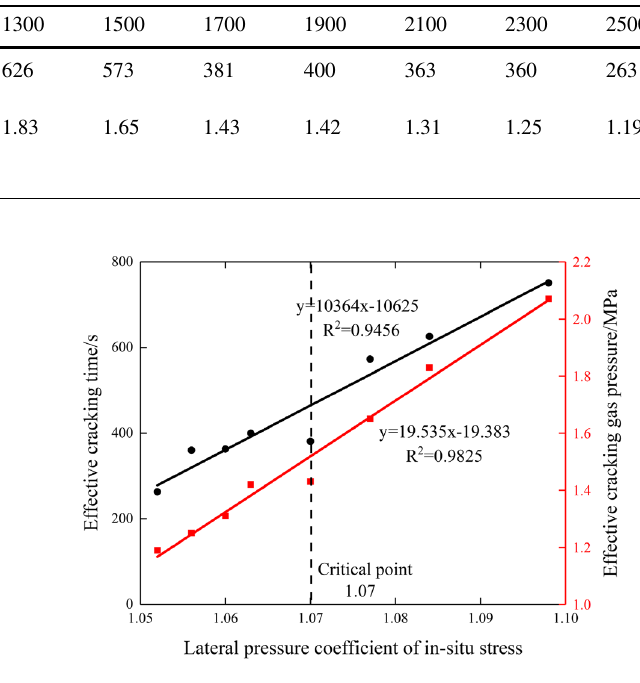
Fig. 5 Variation of effective cracking time and effective cracking gas pressure with average in-situ stress